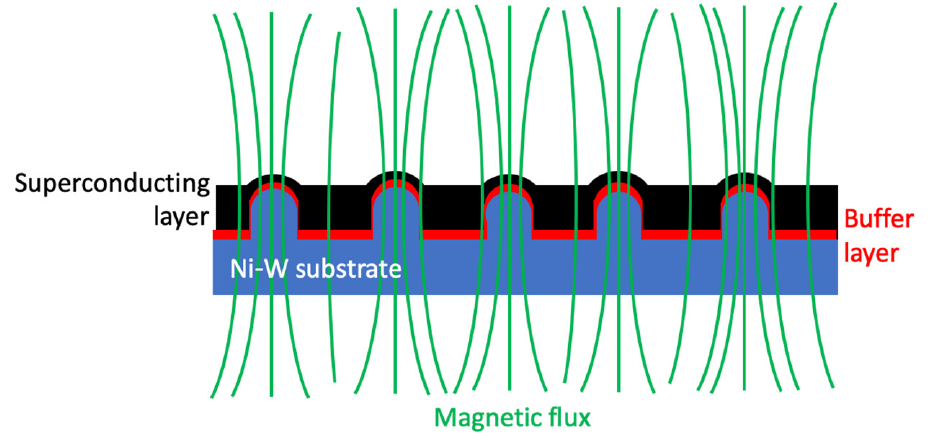
Figure 1. Scheme of a possible way of transferring the laser-generated surface structures in the Ni-W substrate (blue) to the superconducting layer (black) for improving the superconducting properties by pinning the magnetic flux lines (green) at homogeneously distributed sites. The passivating buffer layer (red) prevents chemical reactions between the superconducting layer and the Ni-W substrate.